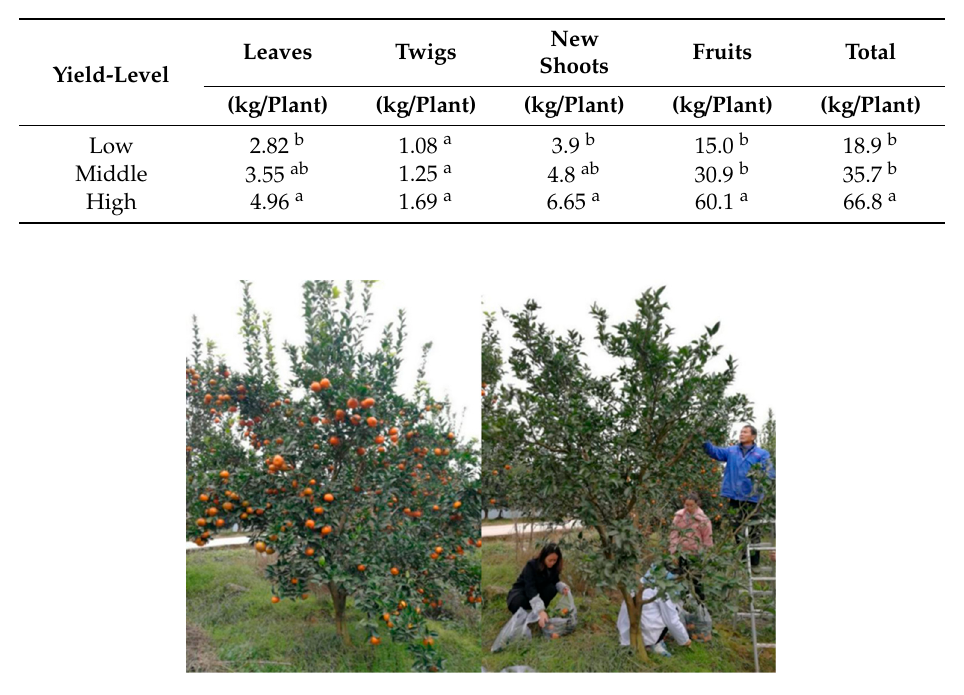
Figure A1. Collecting citrus fruits and recording data.